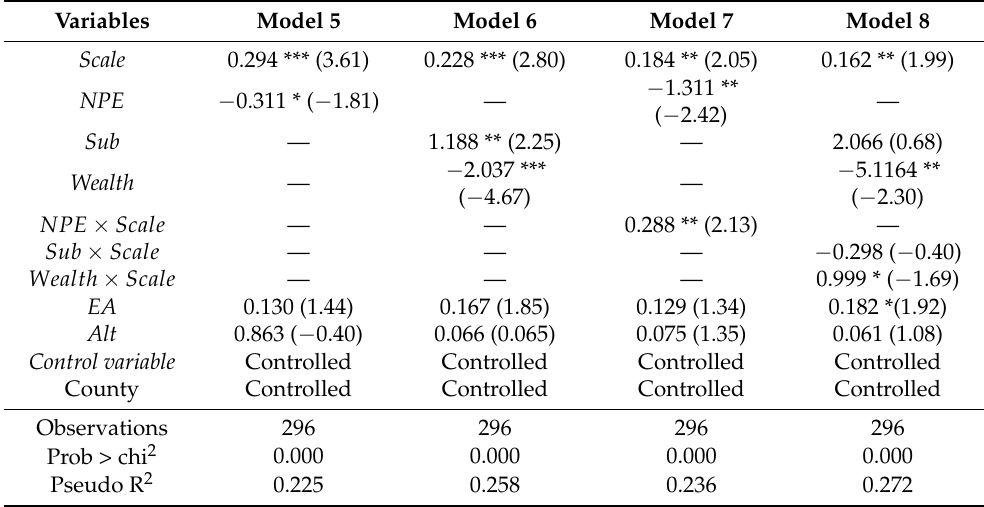
Table 3. Robustness test for the effects of Scale and NPE on No_Tech .